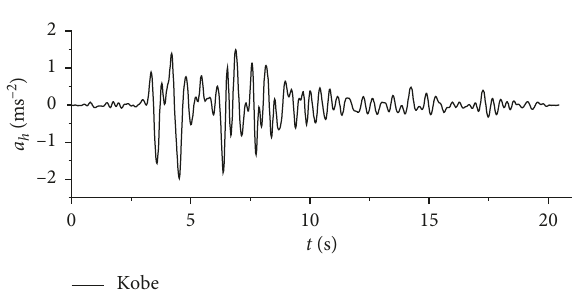
Figure 6: Input earthquake motion.